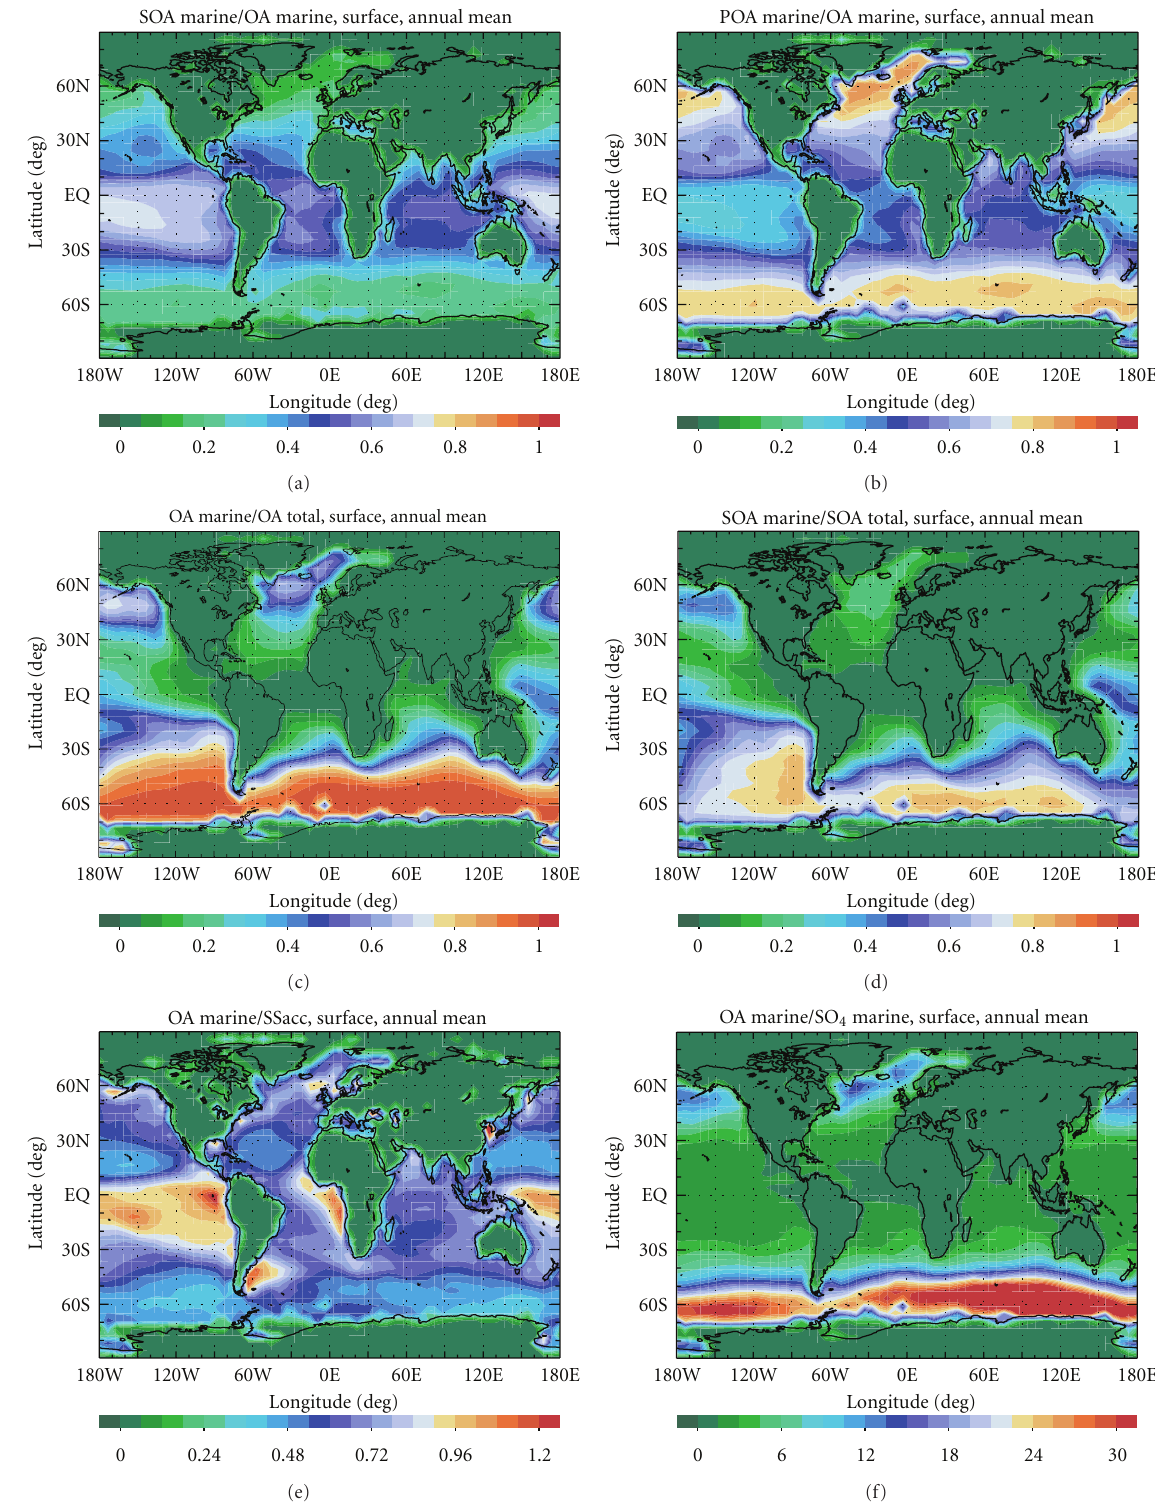
Figure 4: Calculated mean fraction of (a) marine SOA to total marine OA, (b) marine POA to total marine OA, (c) marine OA to total OA, (d) marine SOA to total SOA, (e) marine OA to sea-salt in the accumulation mode, (f) marine OA to marine sulphate. For clarity values over entirely land covered model grids have been